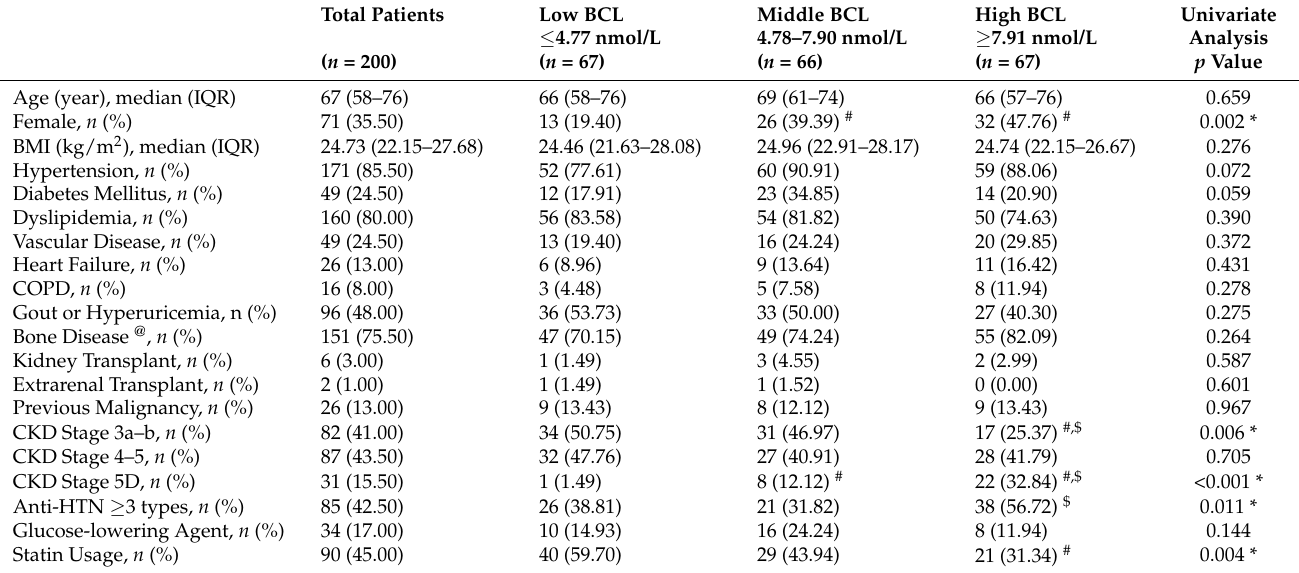
Table 1. Differences in Demographic Profiles and Clinical Characteristics Between Three BCL